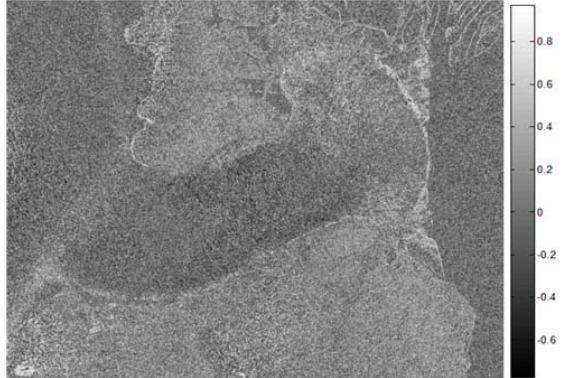
Fig.5. Coherence map of one part of the outlet area of the Taku Glacier generated from two TerraSAR-X repeat cycle scenes with 11 days interval.